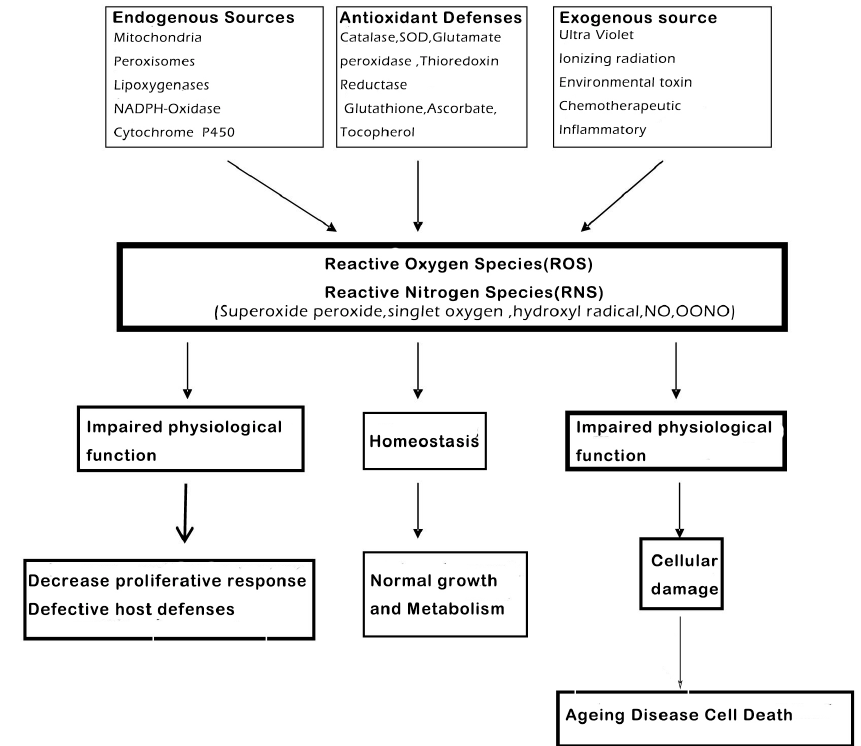
Figure 3. Reactive oxygen (ROS) and nitrogen (RNS) species are highly reactive oxidized molecules, including superoxide, peroxide, singlet oxygen, hydroxyl radical, NO and OONO, that are constantly produced under normal cellular conditions, such as during homeostasis and impaired functions, which could lead to cellular damage, like ageing, disease and cell death (modified from Shetty et al., 2004.) [20]